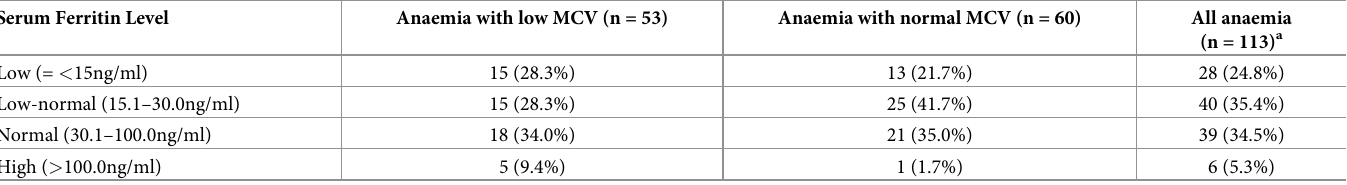
Table 2. Body iron status among females with anaemia.